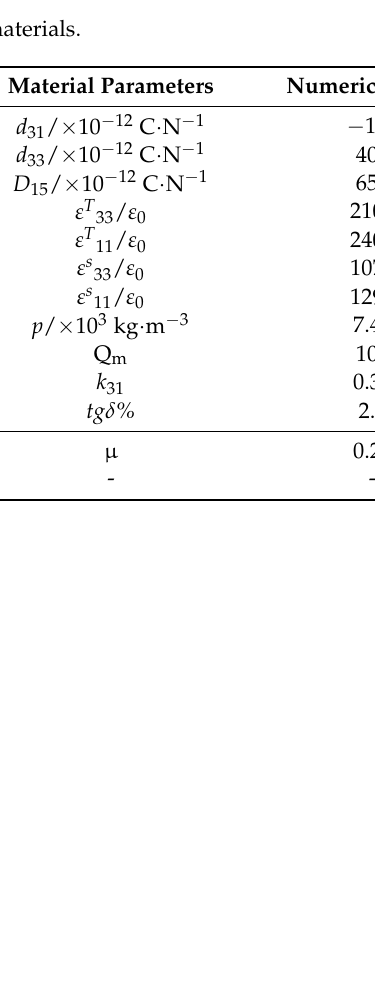
Figure 7. The SECE based on the Buck structure. When the open circuit voltage V p of the piezoelectric energy harvester reached the peak value, the energy accumulation in the piezoelectric material reached the maximum value. At this time, the switch was turned on and the energy accumulated in the internal equivalent capacitance C p was transferred to the inductance through the LC resonance. Taking the positive half cycle as an example, when the voltage V p was greater than zero, the switch S 1 was turned on and the internal equivalent capacitor C p , the inductance L and the energy storage capacitor C S formed a CLC oscillating circuit. The charge in the capac- itor C p was gradually released during the transfer process until the charge was completely transferred. At this stage, the energy transferred to the load was expressed as: